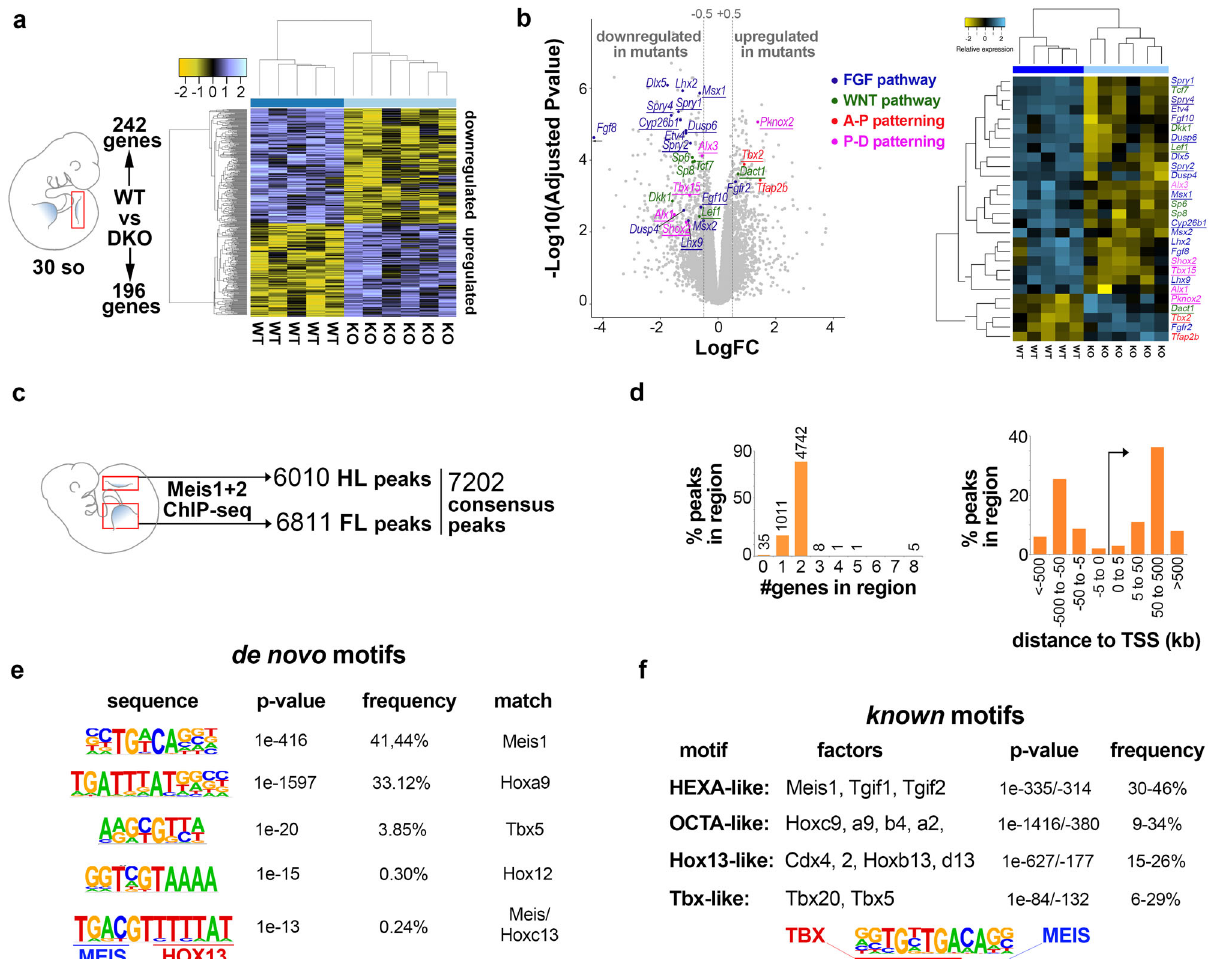
Fig. 3 Molecular analysis of Meis function in limb buds. a RNA-seq analysis comparing wild-type and M1KO;M2KO HLs, showing the clustering of WT and mutant samples by expression pro fi le. b Volcano plot and heat map with the most relevant genes involved in AP patterning, PD patterning, Wnt and Fgf pathways highlighted in color code. p -values are obtained by a Benjamini – Hochberg procedure, which adjusts for multiple comparisons. The underlined highlighted genes show Meis-binding sites in their regulatory regions by ChIP-seq. c – f ChIP-seq analysis, showing the number of binding sites identi fi ed in E10.5 FLs and HLs ( c ), the distribution of Meis peaks with respect to transcriptional units ( d ) and de novo ( e ), and known ( f ) sequence motif identi fi cation. FC: fold change. See the “ Data availability ” section for source